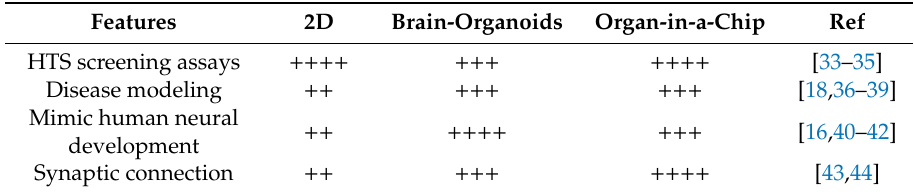
Table 1. Assessment of the advantages of 2D, brain-organoids and Organs-on-a-chip for neural drug discovery. Di ff erences between cell culture technologies were marked with symbols, which the higher score is four crosses and the less